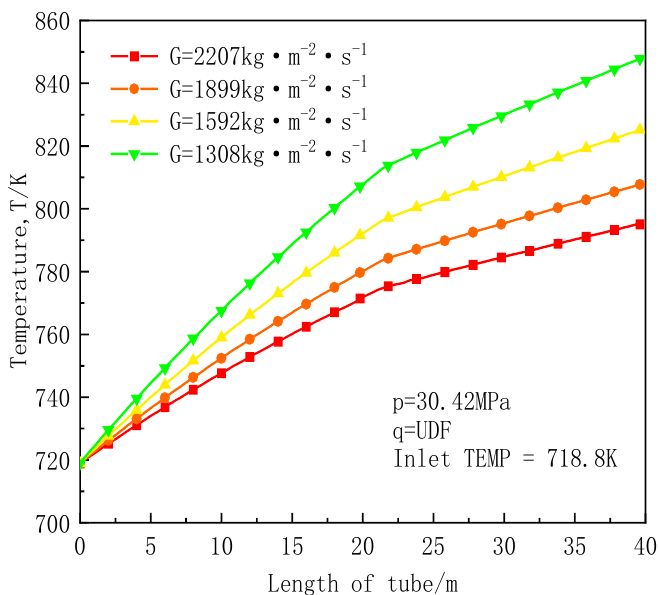
Figure 11. Temperature distribution of the tube length at different mass fluxes ( p = 30.42 MPa, T = 718.8 K, G = 1308~2207 kg/(m 2 · s)).